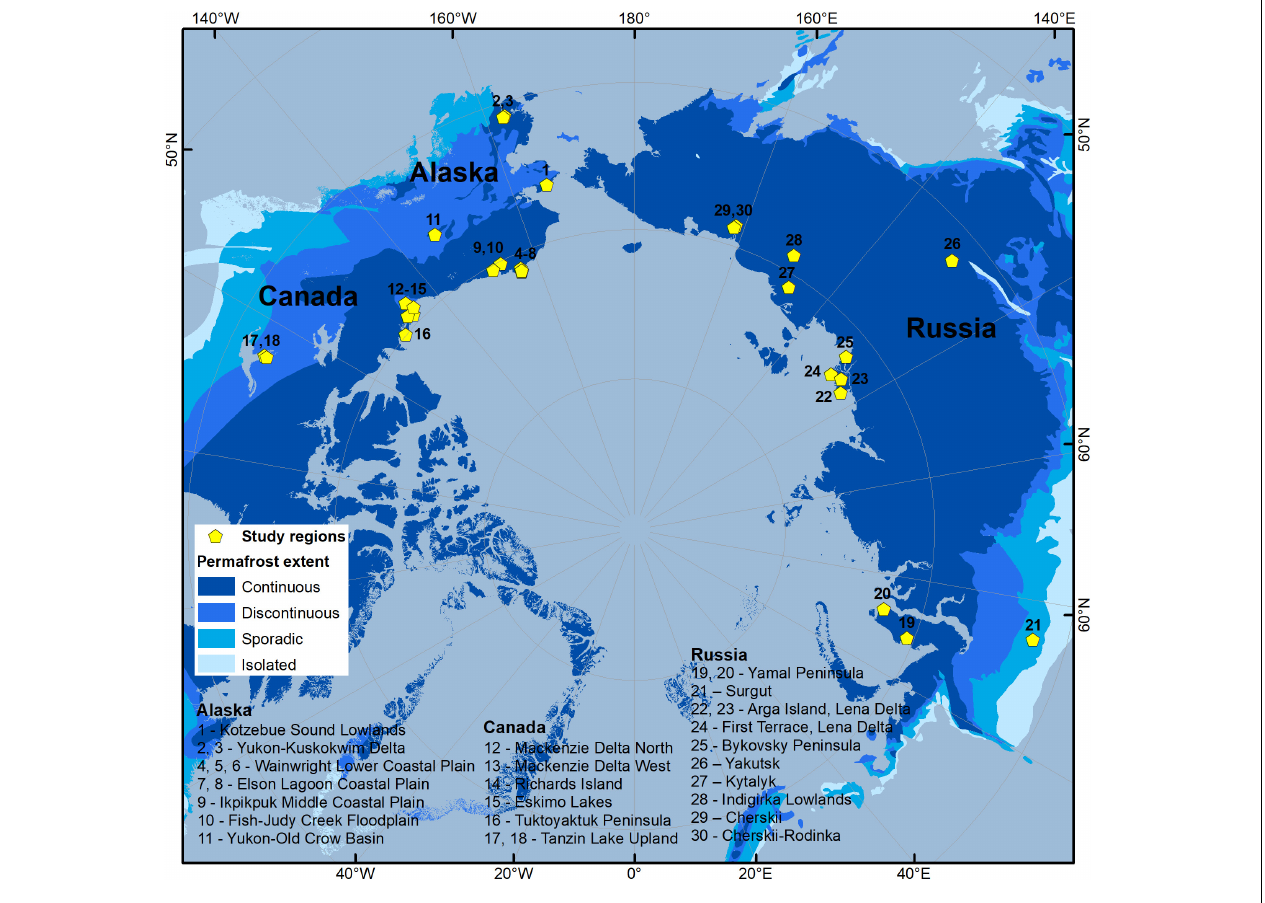
FIGURE 1 | Location of study regions in the